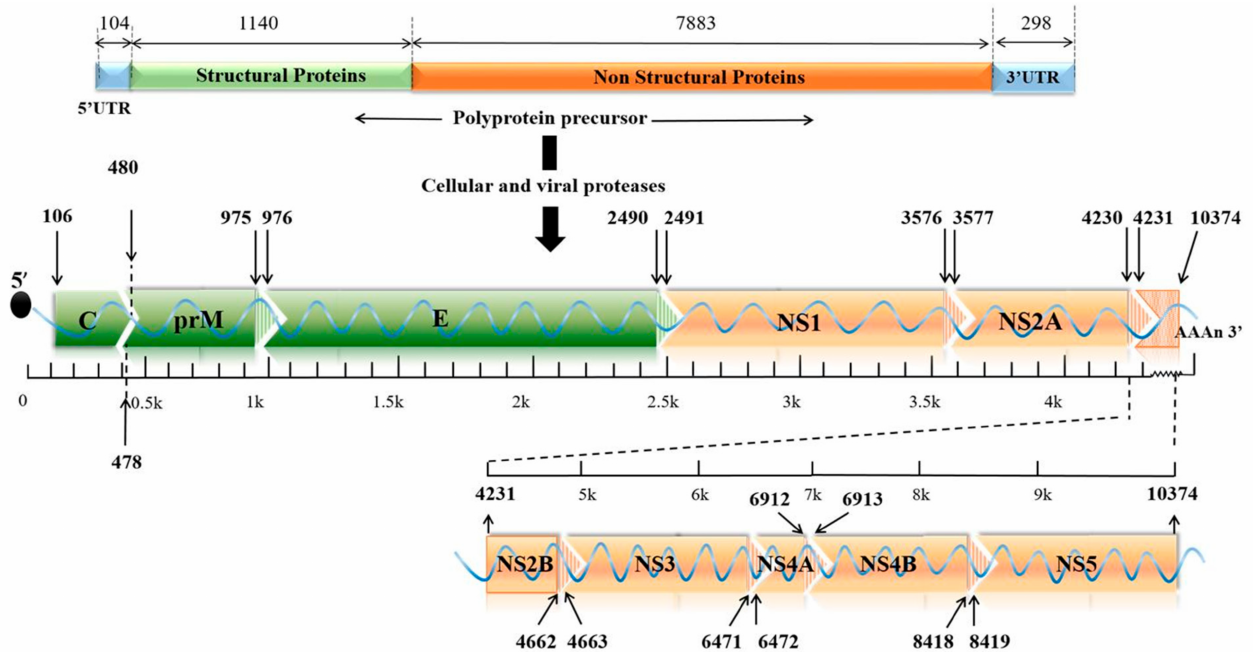
Figure 1. The genomic structure of ZIKV. The genome contains a single ORF encoding three structural proteins (C, prM, and E) and seven non-structural proteins (NS1, NS2A, NS2B, NS3, NS4A, NS4B, and NS5) with two UTRs at both ends. ORF: opening reading frame; C: capsid; prM: premembrane; E: envelope; UTR: untranslated region.